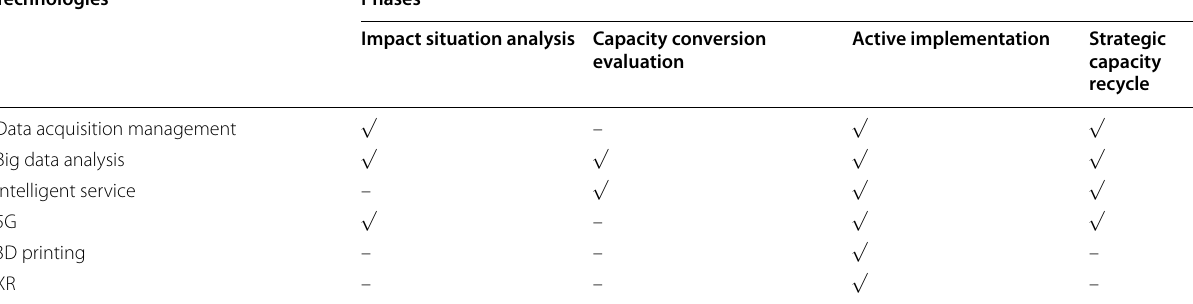
Table 1 Enabling technologies for the four phases in resilient manufacturing strategy